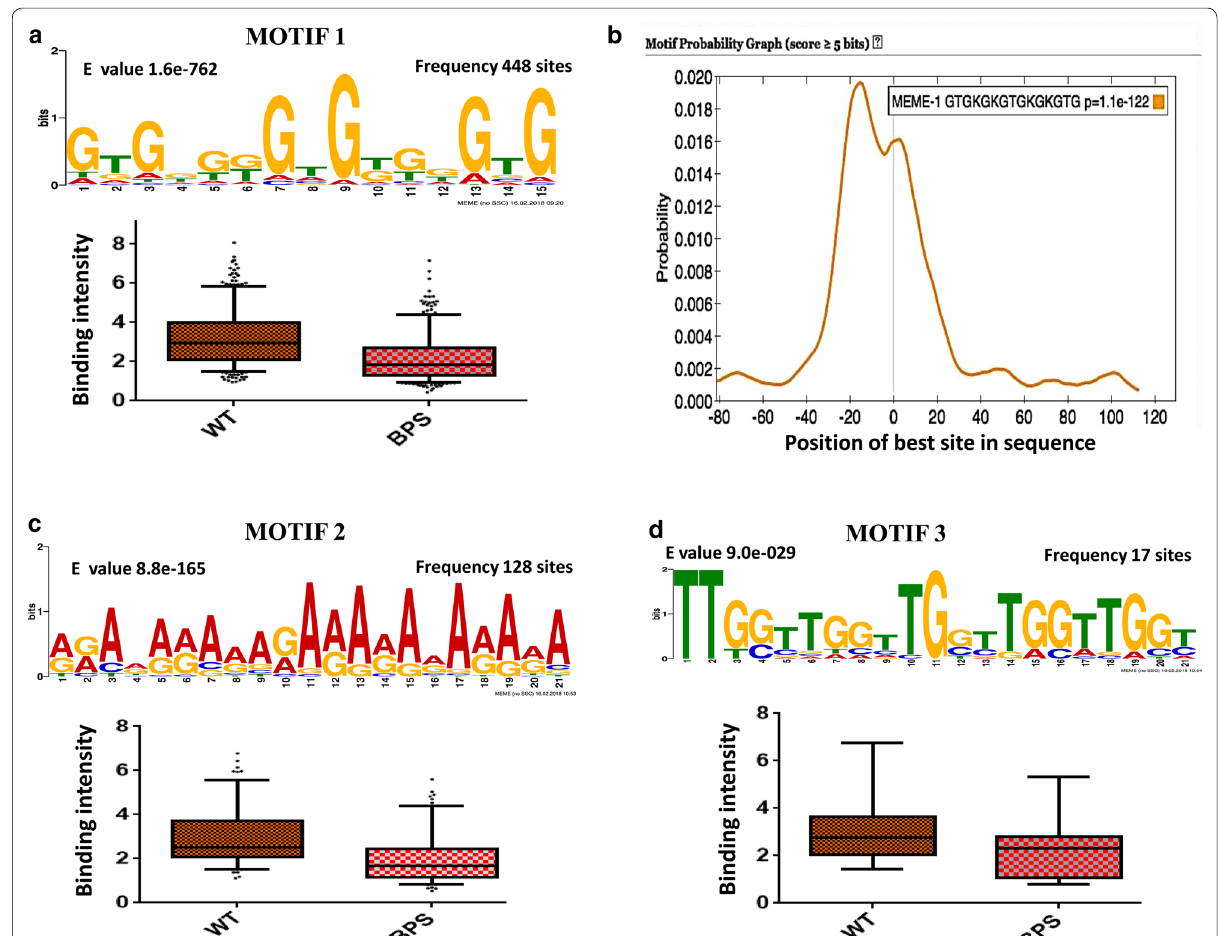
Fig. 9 Hsf1 binding sites prediction: Hsf1 binding peaks are predicted based upon ChIP, peaks using MEME software. ( a ) Motif 1-De novo motif analysis using MEME on Hsf1-binding sites identified this highly significant sequence (E-value in plot ( b ). The motifs with second and third highest frequency are represented as motif 2 ( c ) and motif 3 ( d